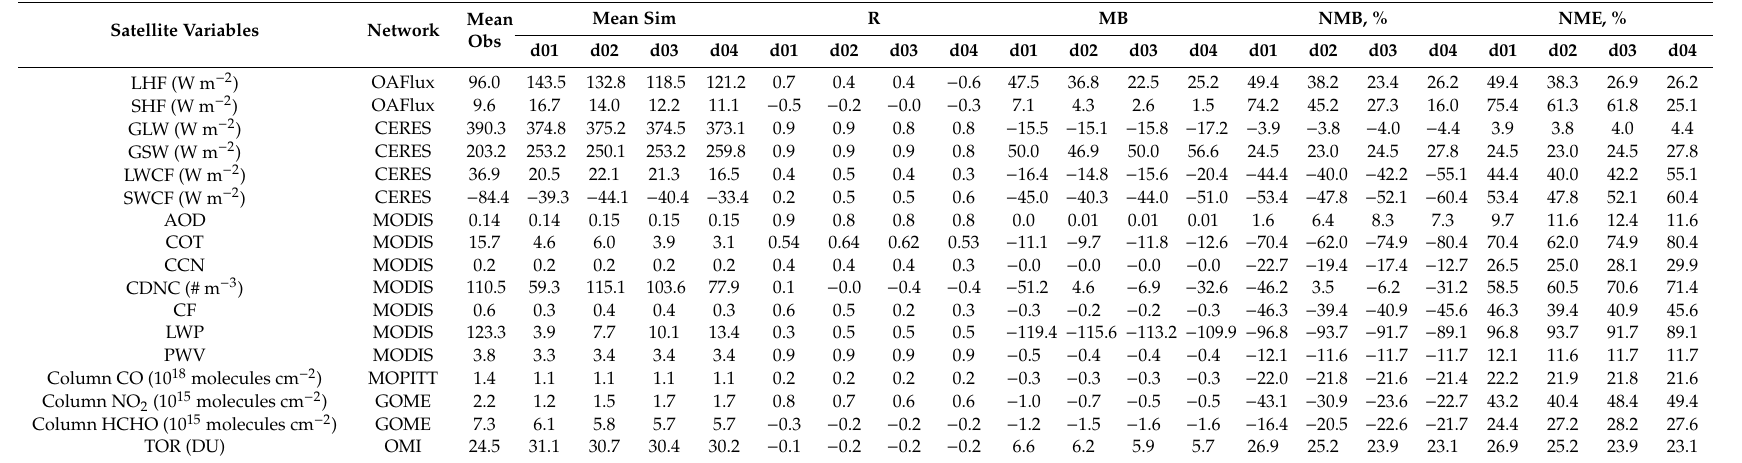
Table 4. Performance statistics of radiative, cloud, heat flux, and column gas variables from WRF / Chem-ROMS simulations at a horizontal grid resolution of 81-km (in d01), 27-km (in d02), 9-km (in d03), and 3-km (in d04) calculated using predictions and observations in d04 for the SPS1 field